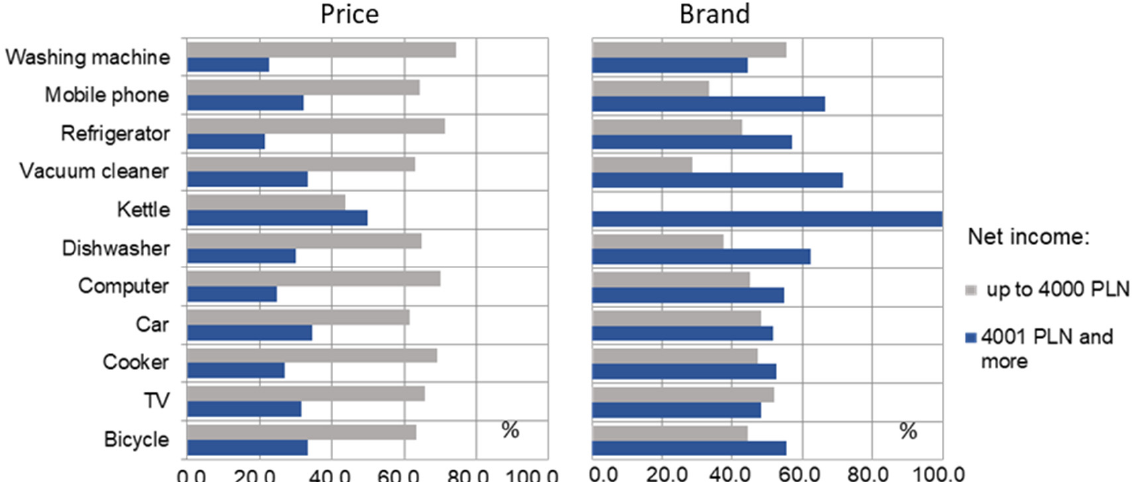
Figure 2. The main determinants of purchases (price and brand) depending on the amount of income: own study.